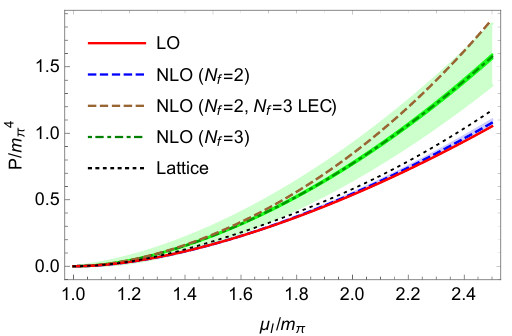
Figure 4 . Normalized Pressure ( P=m 4 ) as a function of (cid:22) I =m (cid:25) at LO (red), at NLO with two (cid:25) (cid:13)avors (blue), NLO with three (cid:13)avors (green), and NLO with two (cid:13)avors and three-(cid:13)avor LECs (brown). See main text for